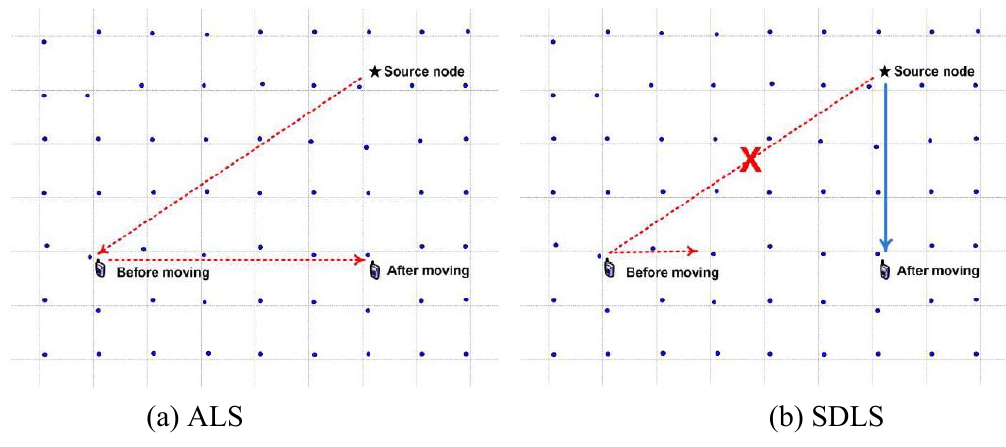
Figure 3. Selection of shortest path